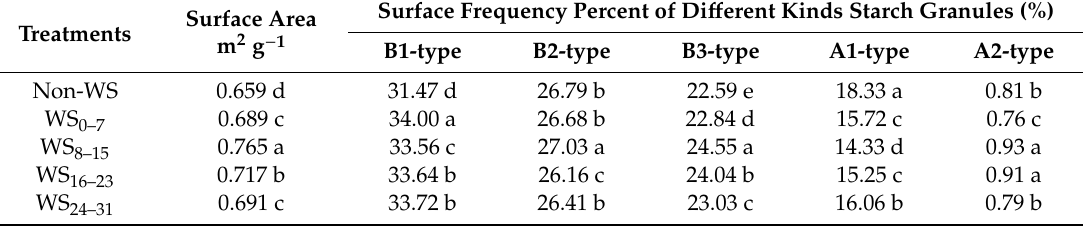
Table 3. E ff ect of combined waterlogging and shading stress during post-anthesis on character values of starch surface area distribution in wheat grains at maturity.